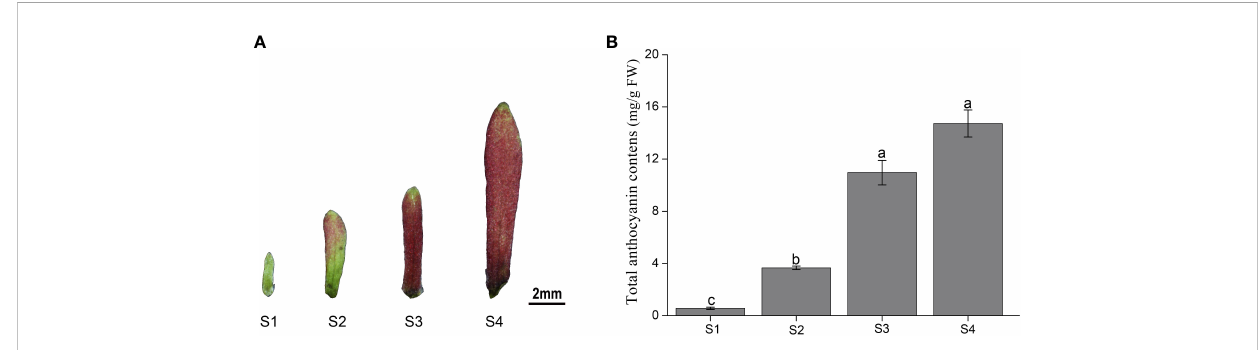
FIGURE 1 Color and total anthocyanin content of Heptacodium miconioides sepals at four developmental stages (S1-S4). (A) The characteristics of the ( H ) miconioides sepal at four growth stages. (B) Changes in total anthocyanin content during sepal development. S1, sepal length = 0.1 cm; S2, sepal length = 0.3 cm; S3, sepal length = 0.5 cm; S4, sepal length=0.8 cm. Values are the means ± standard deviation (SD). Data is the mean of three biological replicates. Different lowercase letters indicated signi fi cant differences at 0.05